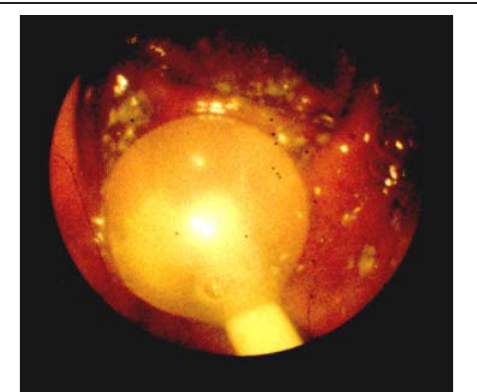
FIGURE 12 - Endoscopic view of Foley catheter pulled opposite abdominal wall.